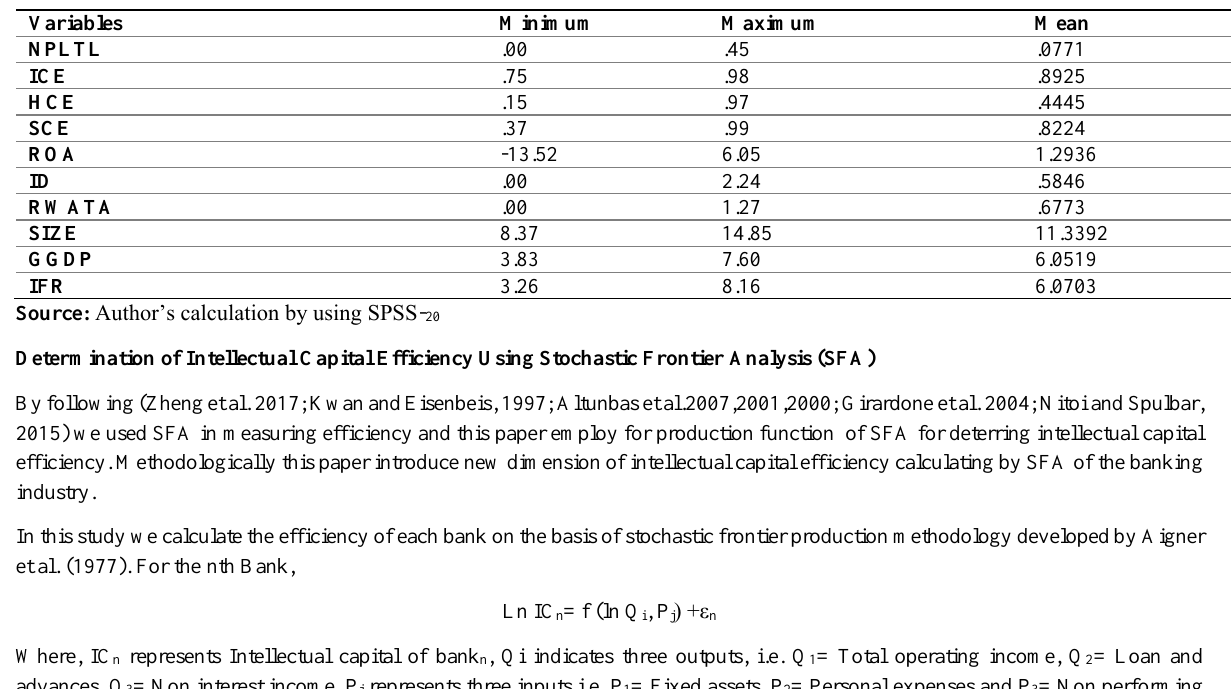
Table 2: Descriptive statistics of all variables (The monetary units are BDT. million where